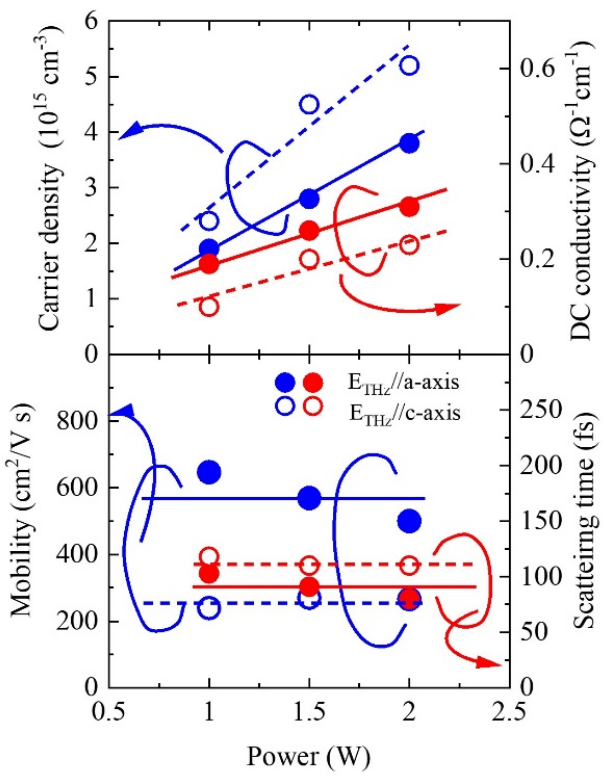
Figure 5. Laser power dependence of excess carrier density, DC conductivity, mobility, and carrier scattering time. These parameters are estimated by fits with the Drude model (E THz //a-axis) and Drude–Smith model (E THz //c-axis).